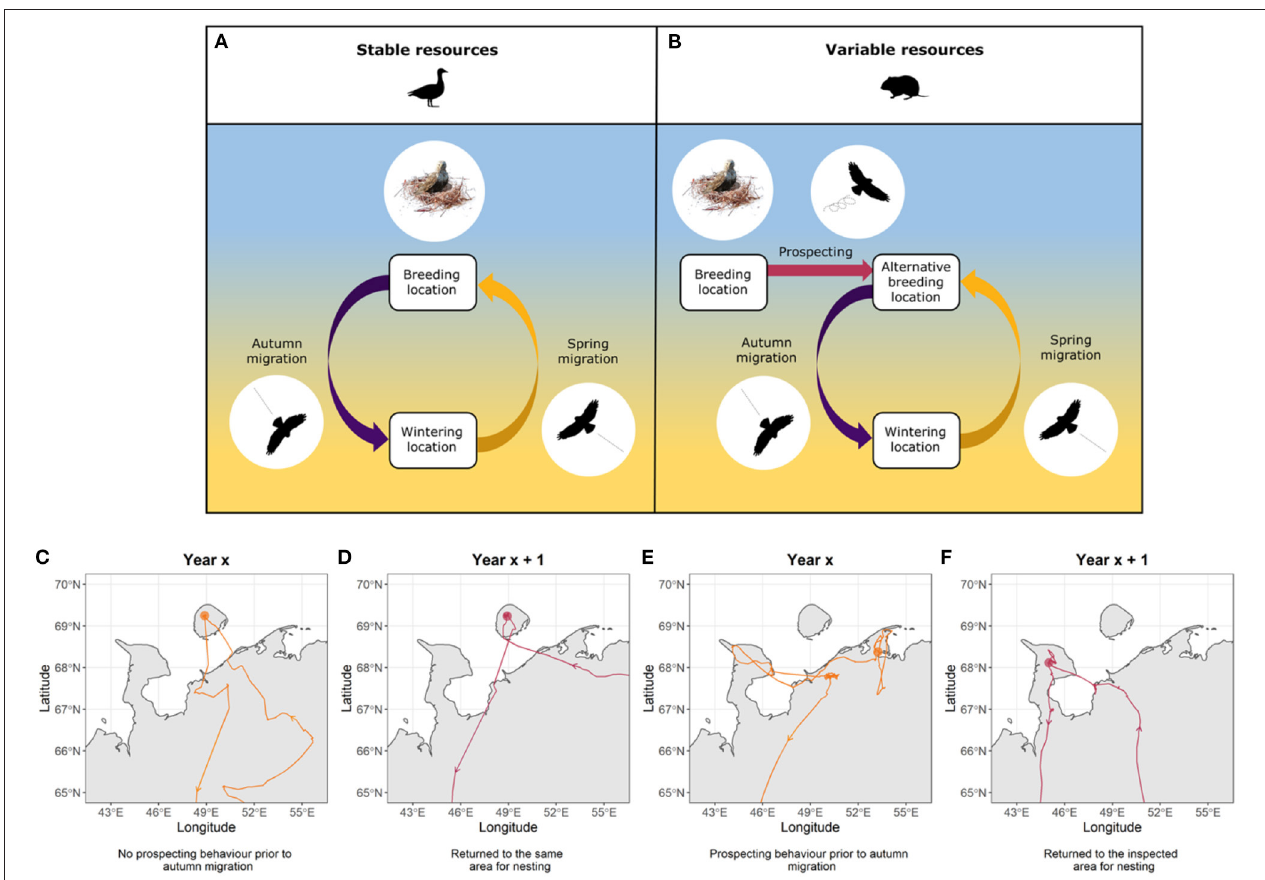
FIGURE 1 | The overall scheme of the hypothesis. (A) If an individual breeds in areas with stable resources, it stays within the nesting area until the end of the breeding season, afterwards migrates to the south to overwinter and in spring returns to the same area for breeding. (B) If an individual breeds in areas with variable resources, it leaves the nesting area and searches for a suitable nesting area for the following year. After this phase of prospecting movement, it migrates to the wintering area and after spring migration, it attempts to breed in the suitable nesting area that it found in the previous summer. Exemplary trajectories for two consecutive years of (C,D) individual that breeds in areas with stable resources and (E,F) individual that breeds in areas with variable resources. Nest locations are marked with dots and arrows represent movement